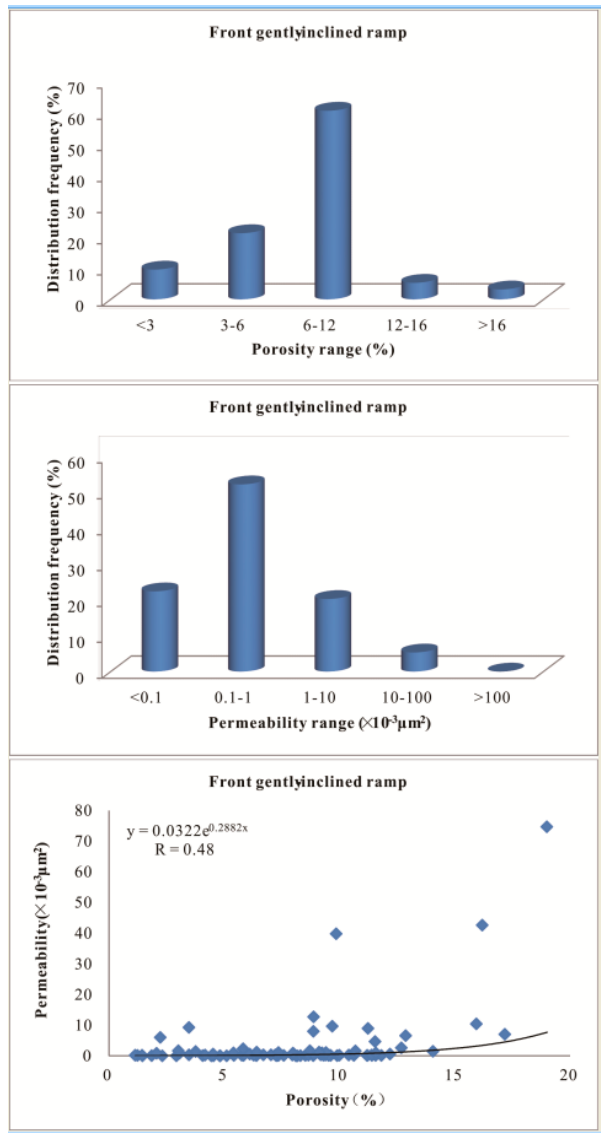
Figure 11. Physical properties of reservoirs and correlation plot between porosity permeability of Callovian-Oxfordian Stage.